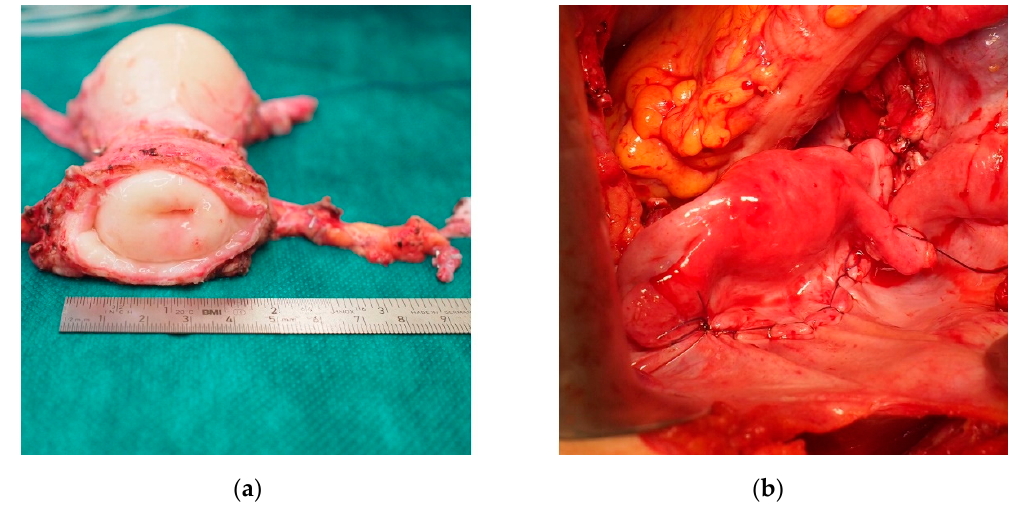
Figure 1. ( a ) Uterus graft from a deceased donor during back-table surgery. ( b ) Uterus graft transplanted in an orthotopic position in the lesser pelvis.